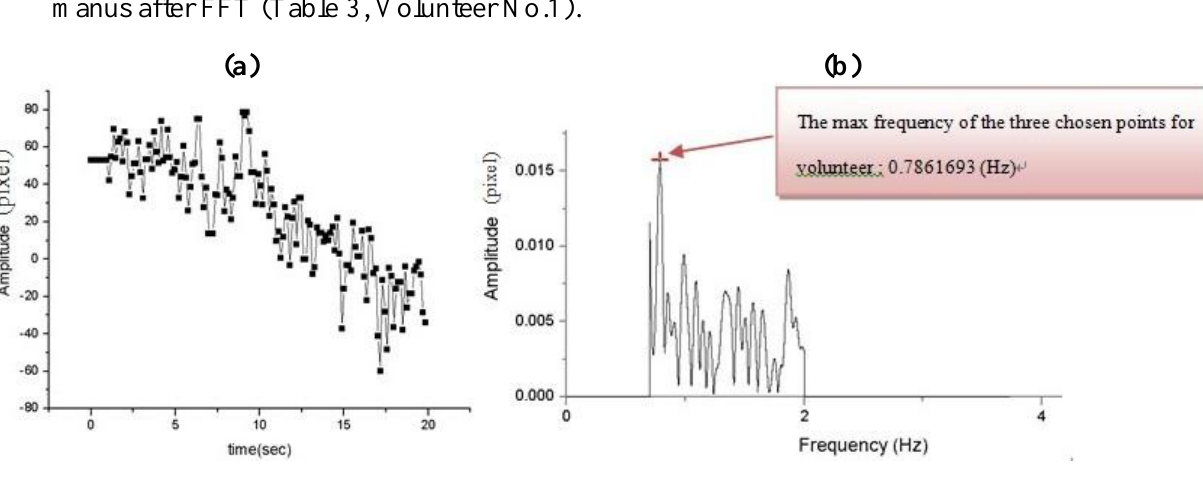
Figure 10. Measurement of the postural action tremor of the dorsum manus of a Parkinson’s disease patient by the Parkinson's disease measurement system: (a) original data showing centroid variation of the laser line over time and (b) the changes in the vibration frequency of the dorsum manus after FFT (Table 4, Volunteer No.1).